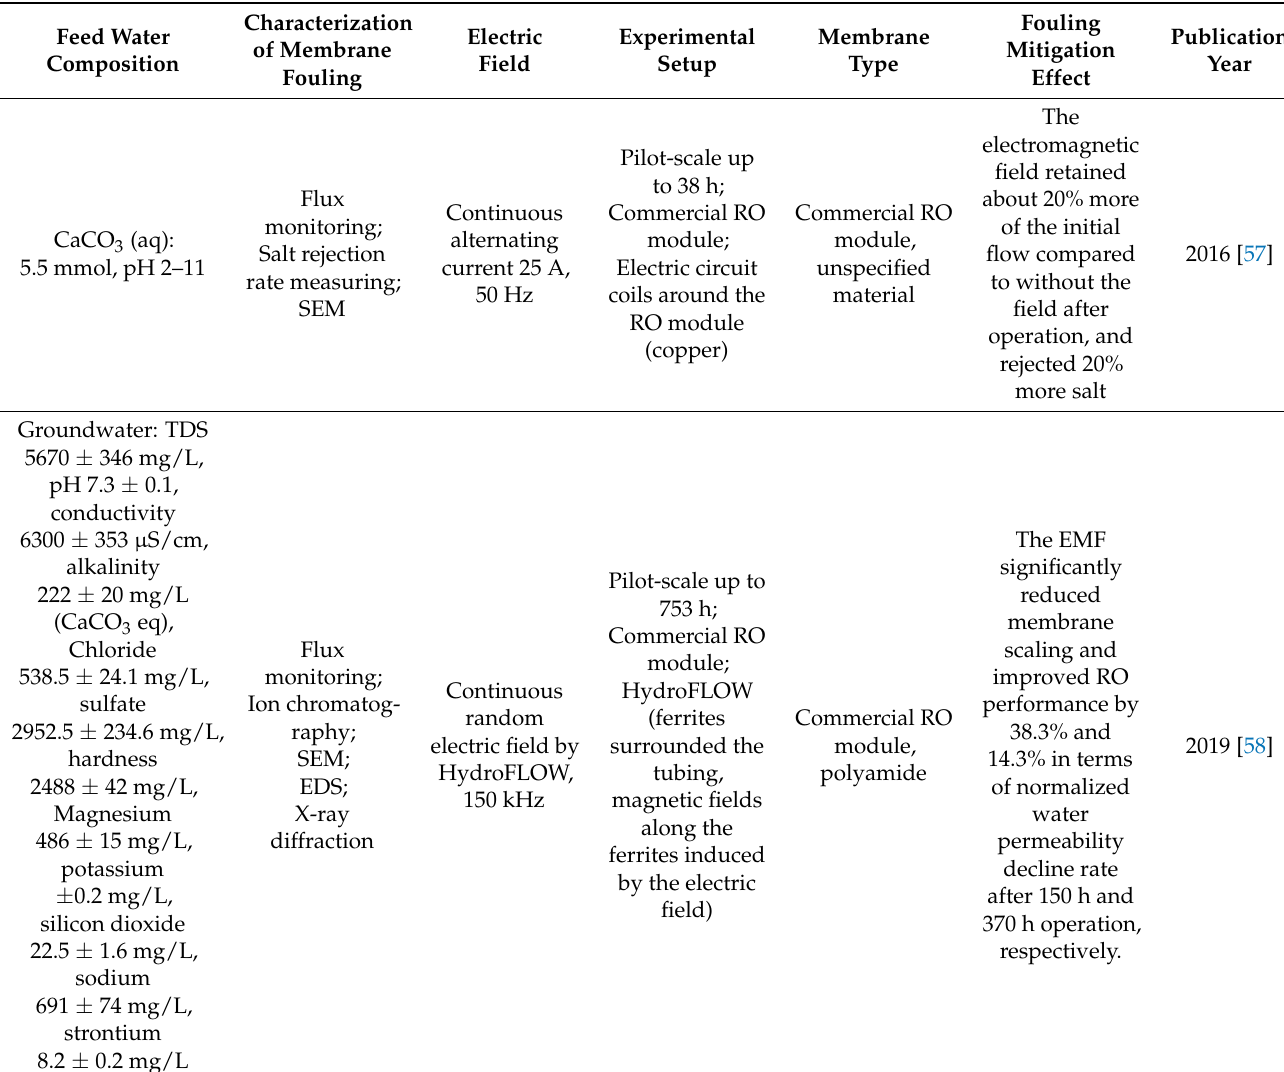
Table 4. Summary of electrofiltration studies for forward osmosis and reverse